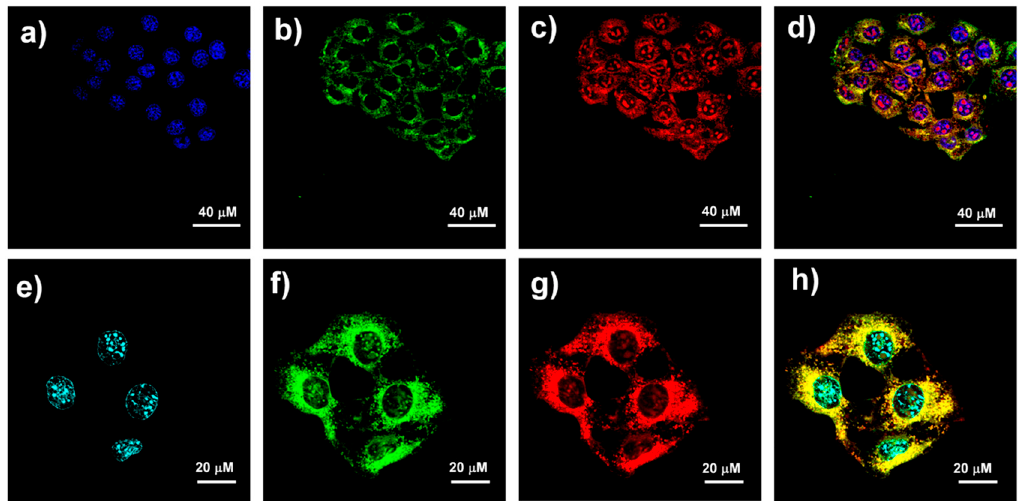
Figure 5. The colocalization assay by the CLSM. 4T1 cells stained with: ( a ) Hoechst 3342; ( b ) Mito-tracker Green; ( c ) QICY, which were separately imaged to acquire the merged picture ( d ). 4T1 cells stained with: ( e ) Hoechst 3342; ( f ) SYTO ® RNASelect™; ( g ) QICY, which were separately imaged to acquire the merged picture ( h ).